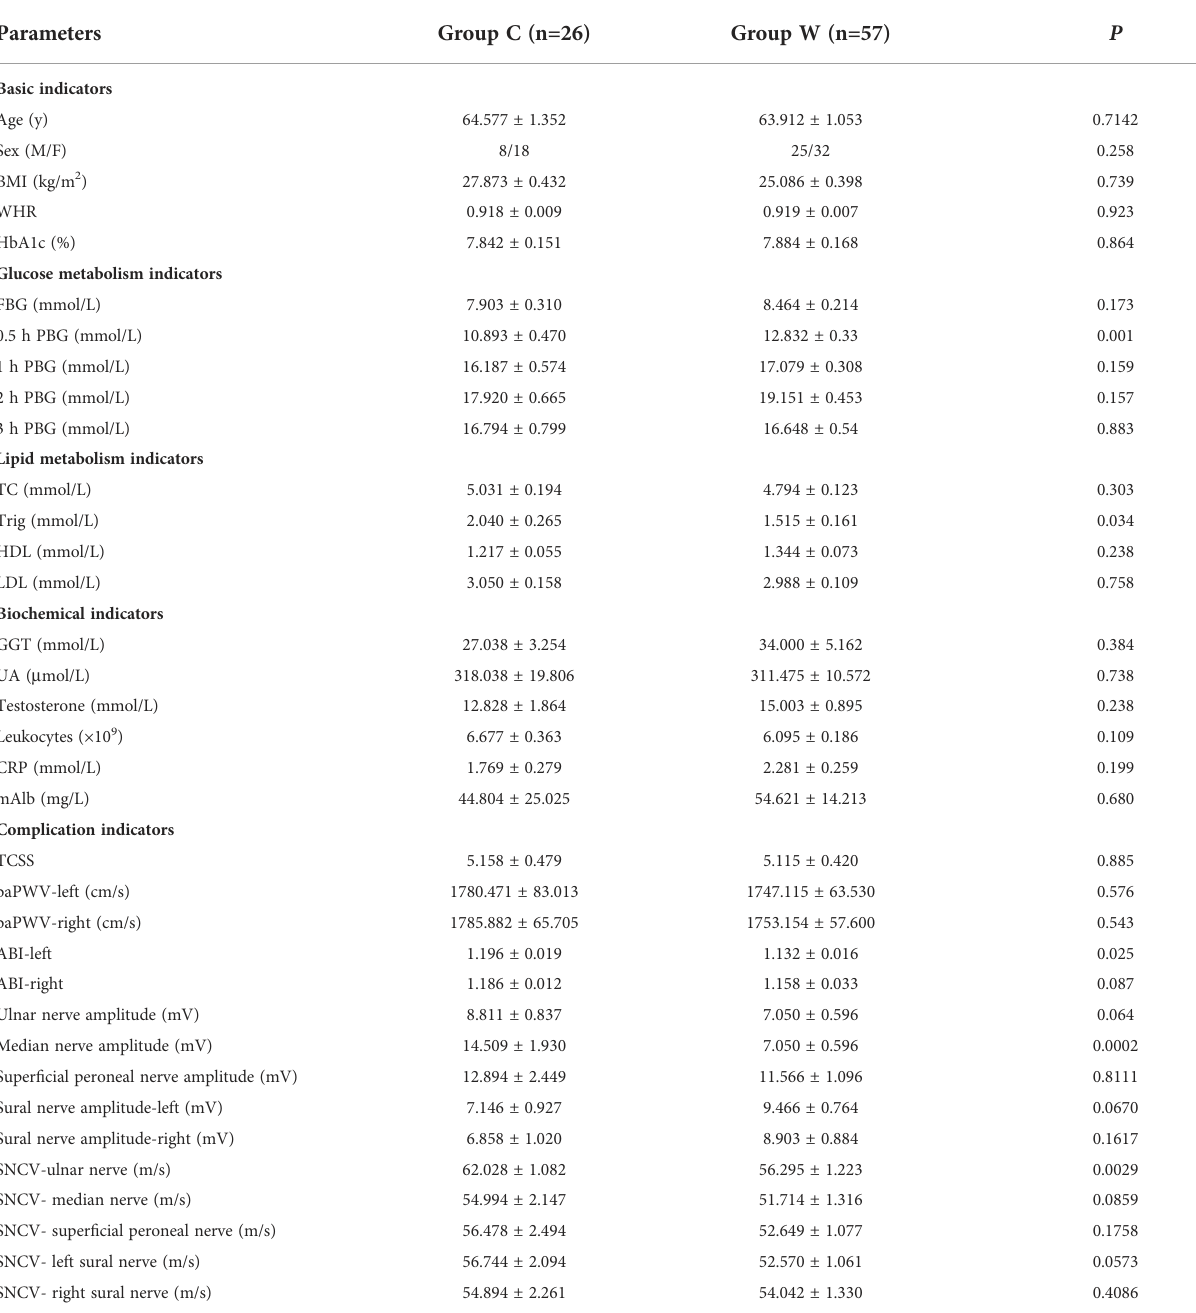
TABLE 1 Baseline characteristics of study